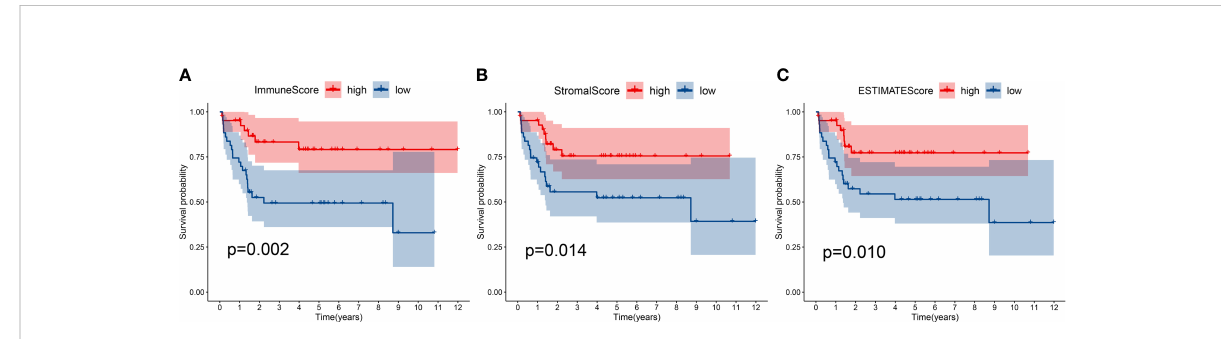
FIGURE 2 Kaplan-Meier survival analysis. Patients with a higher immune score (A) , stromal score (B) and ESTIMATE score (C) had a better